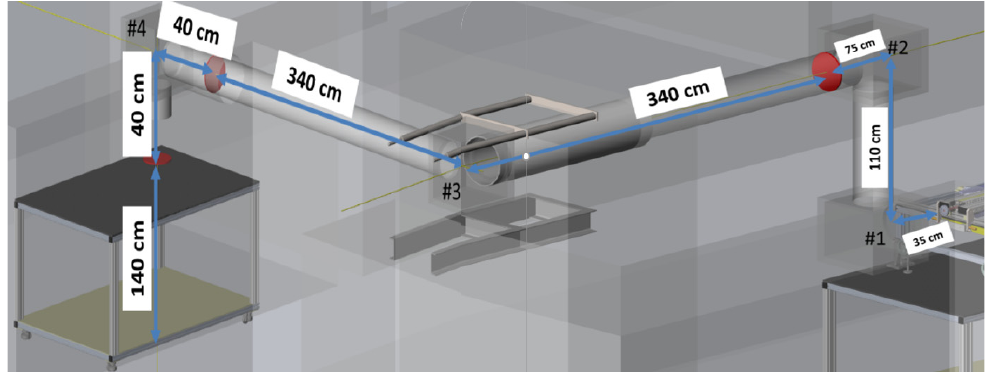
Figure 2. THz transmission line.